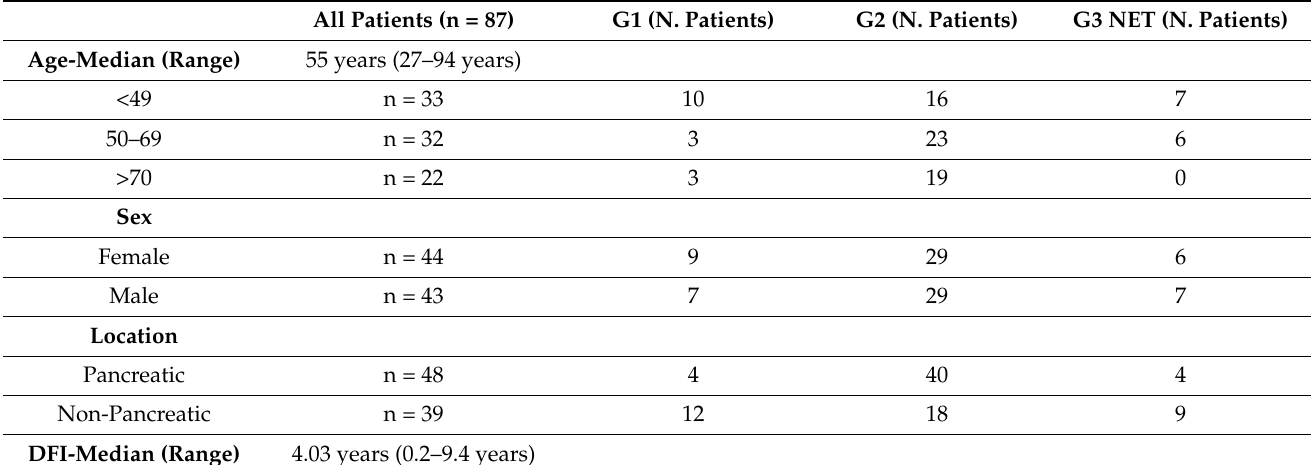
Table 1. Clinical